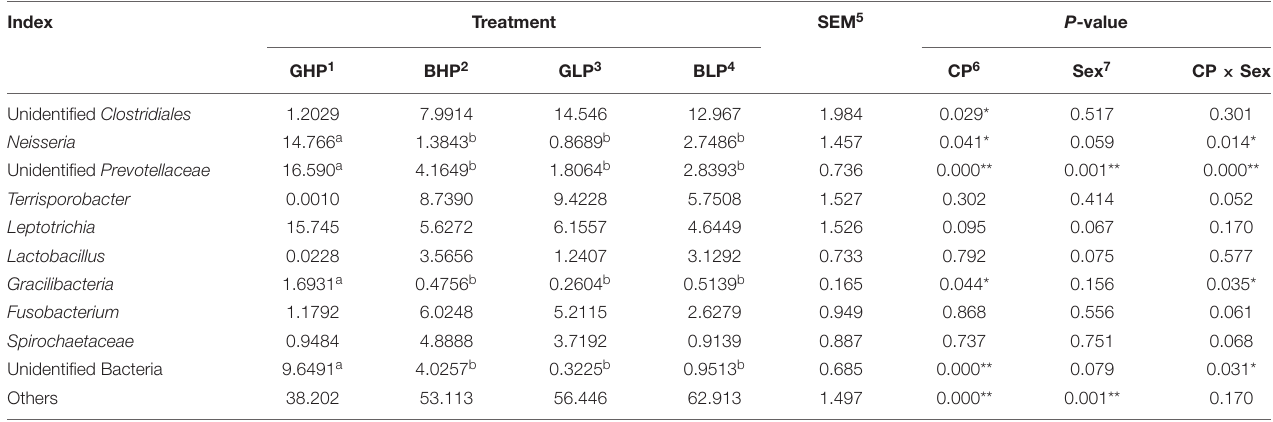
TABLE 3 | Relative abundance of microbial community (Top 10, %) structure in colonic content at genus level from each group.